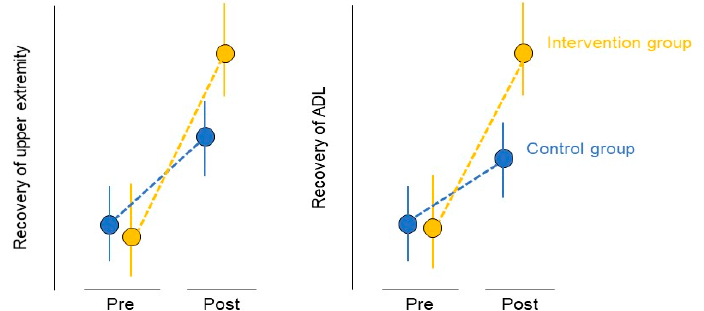
Figure 7. Expected results. ADL, activities of daily living. In the administered occupational therapy, the intervention group is defined by (1) setting the difficulty level of functional exercises, (2) providing an adequate amount of exercise, and (3) the method of goal setting. Therefore, the use-dependent plasticity can be promoted more effectively in the interventional group than in the conventional occupational therapy group, and the patients’ motor functions are expected to improve. Improvement of motor function is expected to contribute to the improvement of patients’ ADL.